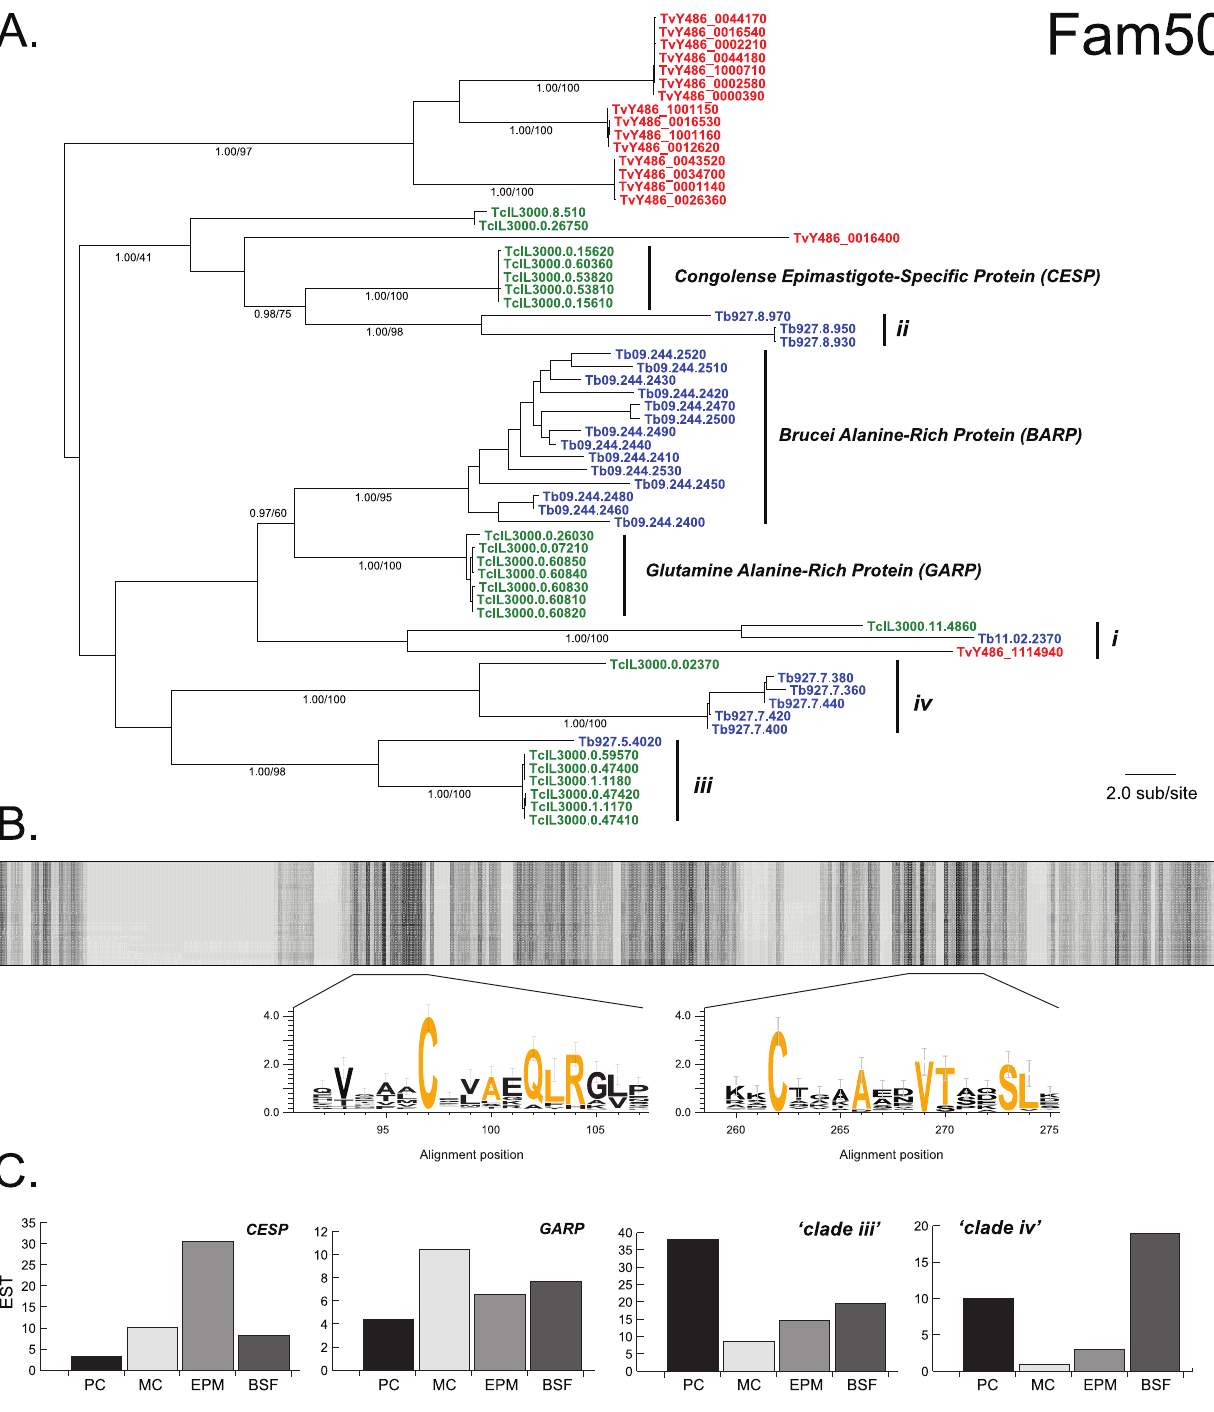
Figure 3. Bayesian phylogeny and expression of BARP / GARP -like genes (Fam50). A . The phylogram was estimated from a multiple protein sequence alignment of 307 characters. The tree is mid-point rooted. Selected nodes are supported by posterior probability values and non- parametric bootstraps generated from a maximum likelihood analysis using an LG model with rate heterogeneity. B . Cartoon of sequence conservation across the Fam50 protein sequence alignment, darker shading reflects conservation. Two conserved regions are expanded to show sequence motifs in WebLogo v2.8.2. format [106]; ubiquitous residues are shaded red. C . Histograms showing the number of T. congolense EST corresponding to each of four clades in A, ( CESP , GARP , subfamily ‘ iii ’ and subfamily ‘ iv ’), recovered from four life stages: procyclic (PC), metacyclic (MC), epimastigote (EPM) and bloodstream form (BSF); data from [41].